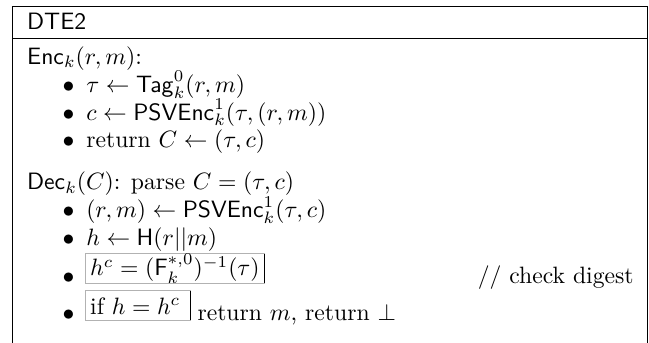
Table 4: DTE2 leakage-resilient authenticated